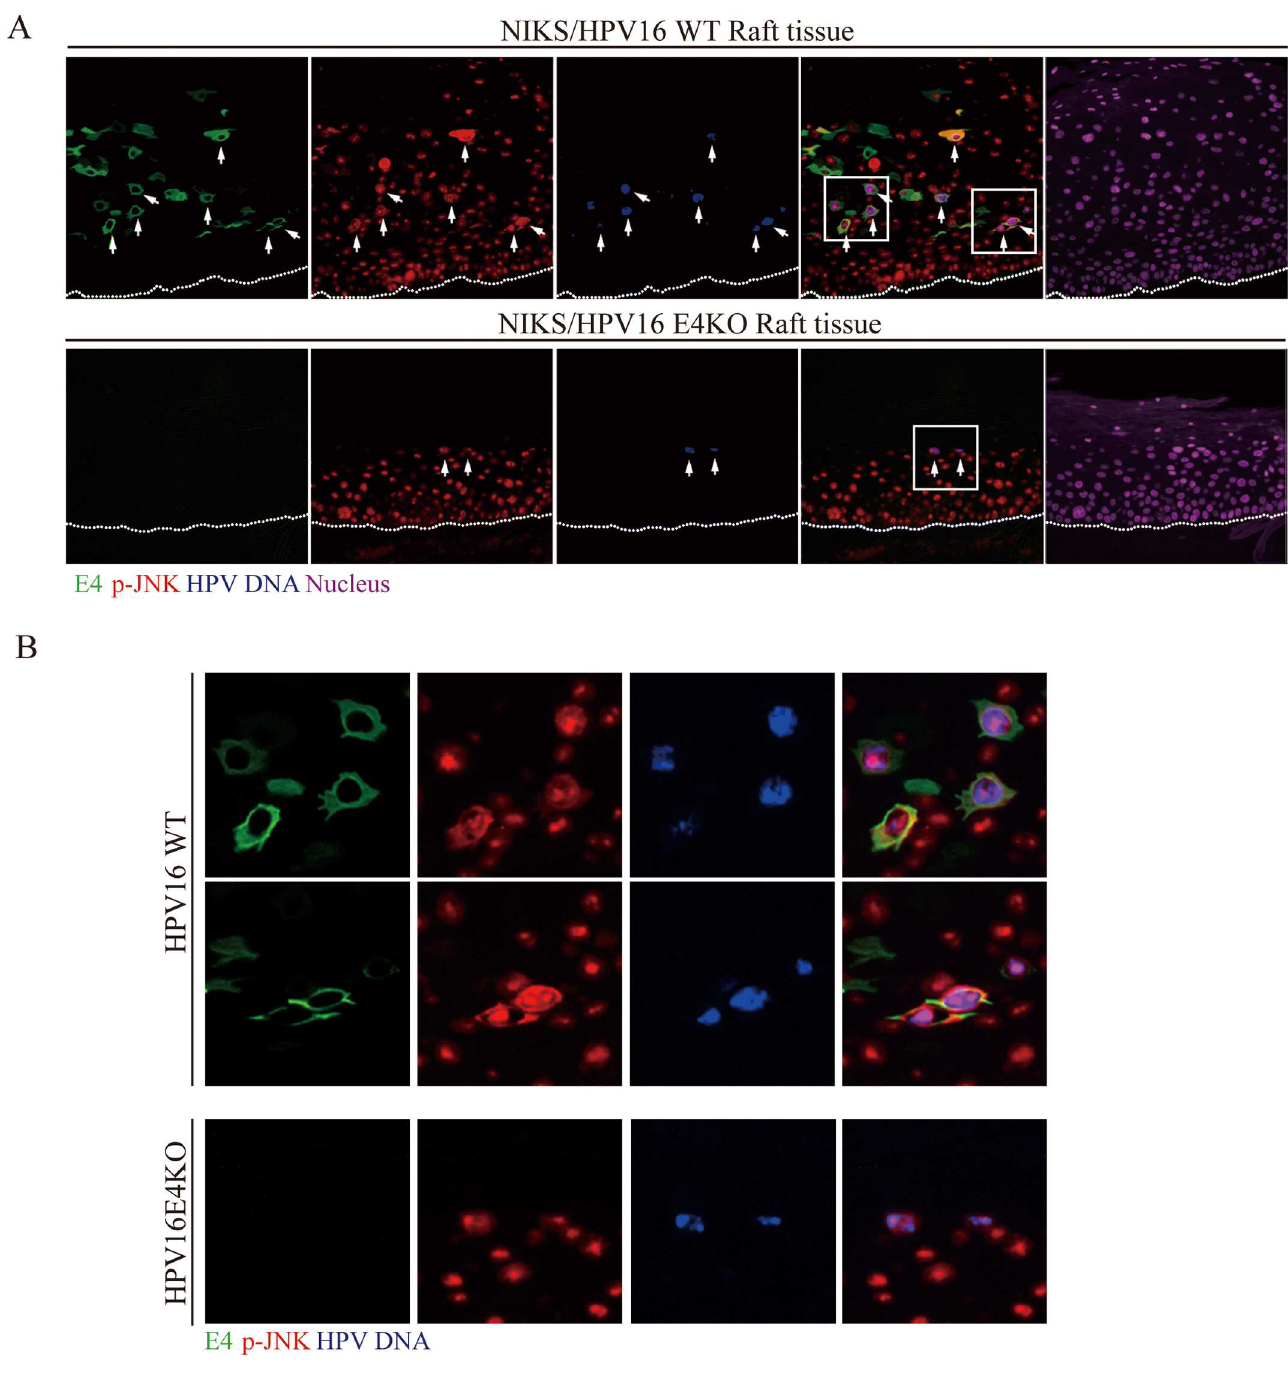
Fig 9. Viral genome amplification during the productive life cycle occurs in cell co-expressing both 16E1^E4and activated cytoplasmic JNK. (A) Raft sections derivedfrom NIKS cells harboringHPV16 WT or E4KO genomeswere analysedat day 14 post-differentiation by quadruple staining for E1^E4 (green), p-JNK (red), nuclear DNA (magenta; DAPI, colour modifiedusing imageJ)and HPV16 genomicDNA (blue, in situ hybridization,colourmodified using imageJ). Efficient viral genomeamplification is confinedto the stainingfor cytoplasmic E4 and cytoplasmic phosphor-JNK-positive upper epithelial layers of WT rafts. In the E4KO rafts a lower level of genome amplification can occur in cells that are negative for cytoplasmicphosphor-JNK. Such cells are typically in the upper p-JNK-staining layers and typically show only nuclear p-JNK staining.The dotted lines indicate the position of the basal layer. Images were captured using a 10x objective. (B) Enlargedareas of the regions boxedin (A) to show the E4/p-JNK patterns in cells known to be supportingHPV16 genomeamplification.